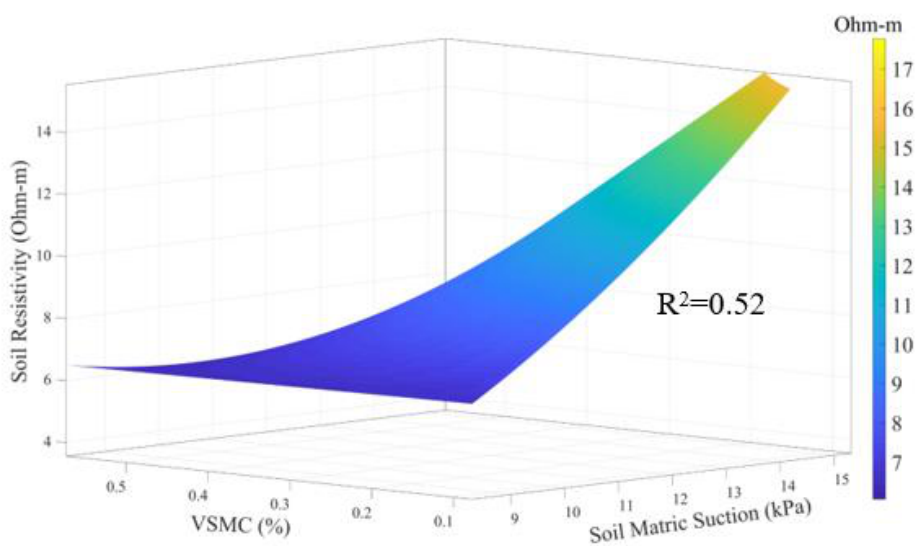
Figure 33. Three-dimensional illustration of field-based soil resistivity function (1 kPa = 20.89 psf; 1 mm = 0.0396 in).